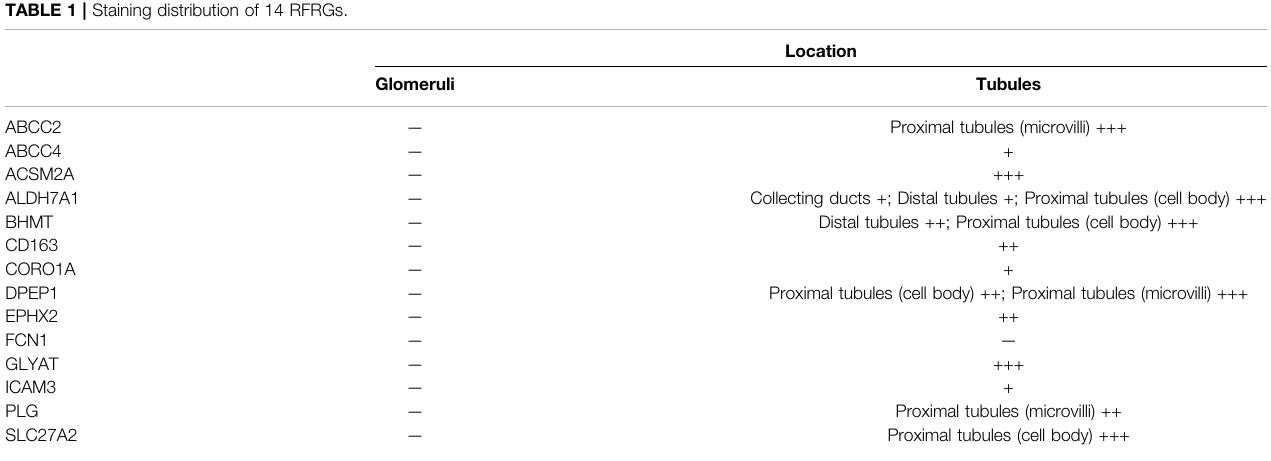
TABLE 1 | Staining distribution of 14